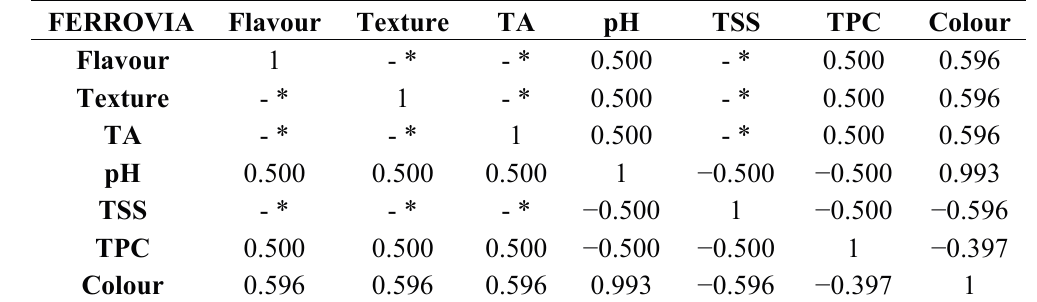
Table 9. Correlation between physicochemical and sensory attributes in the Ferrovia cultivar.